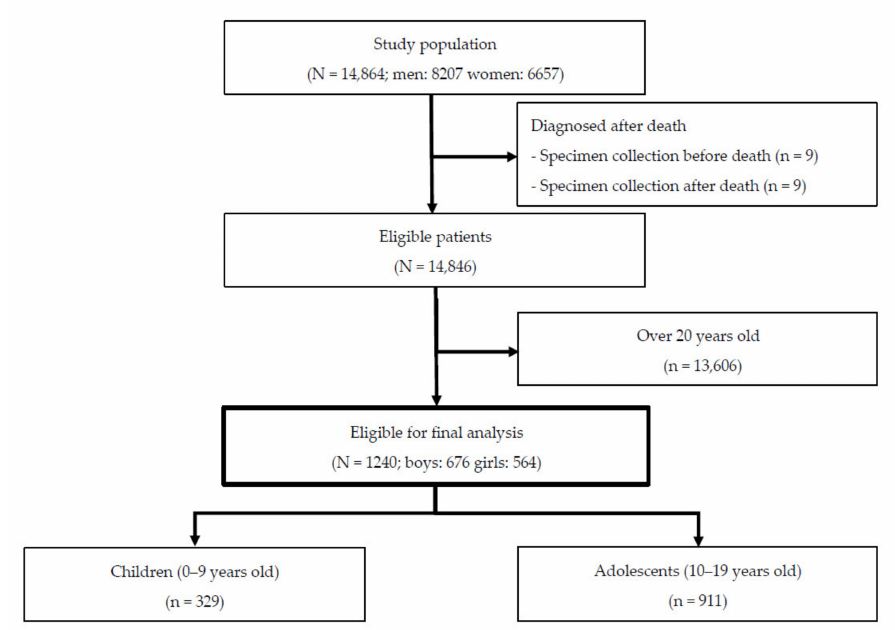
Figure 1. Patient flowchart.